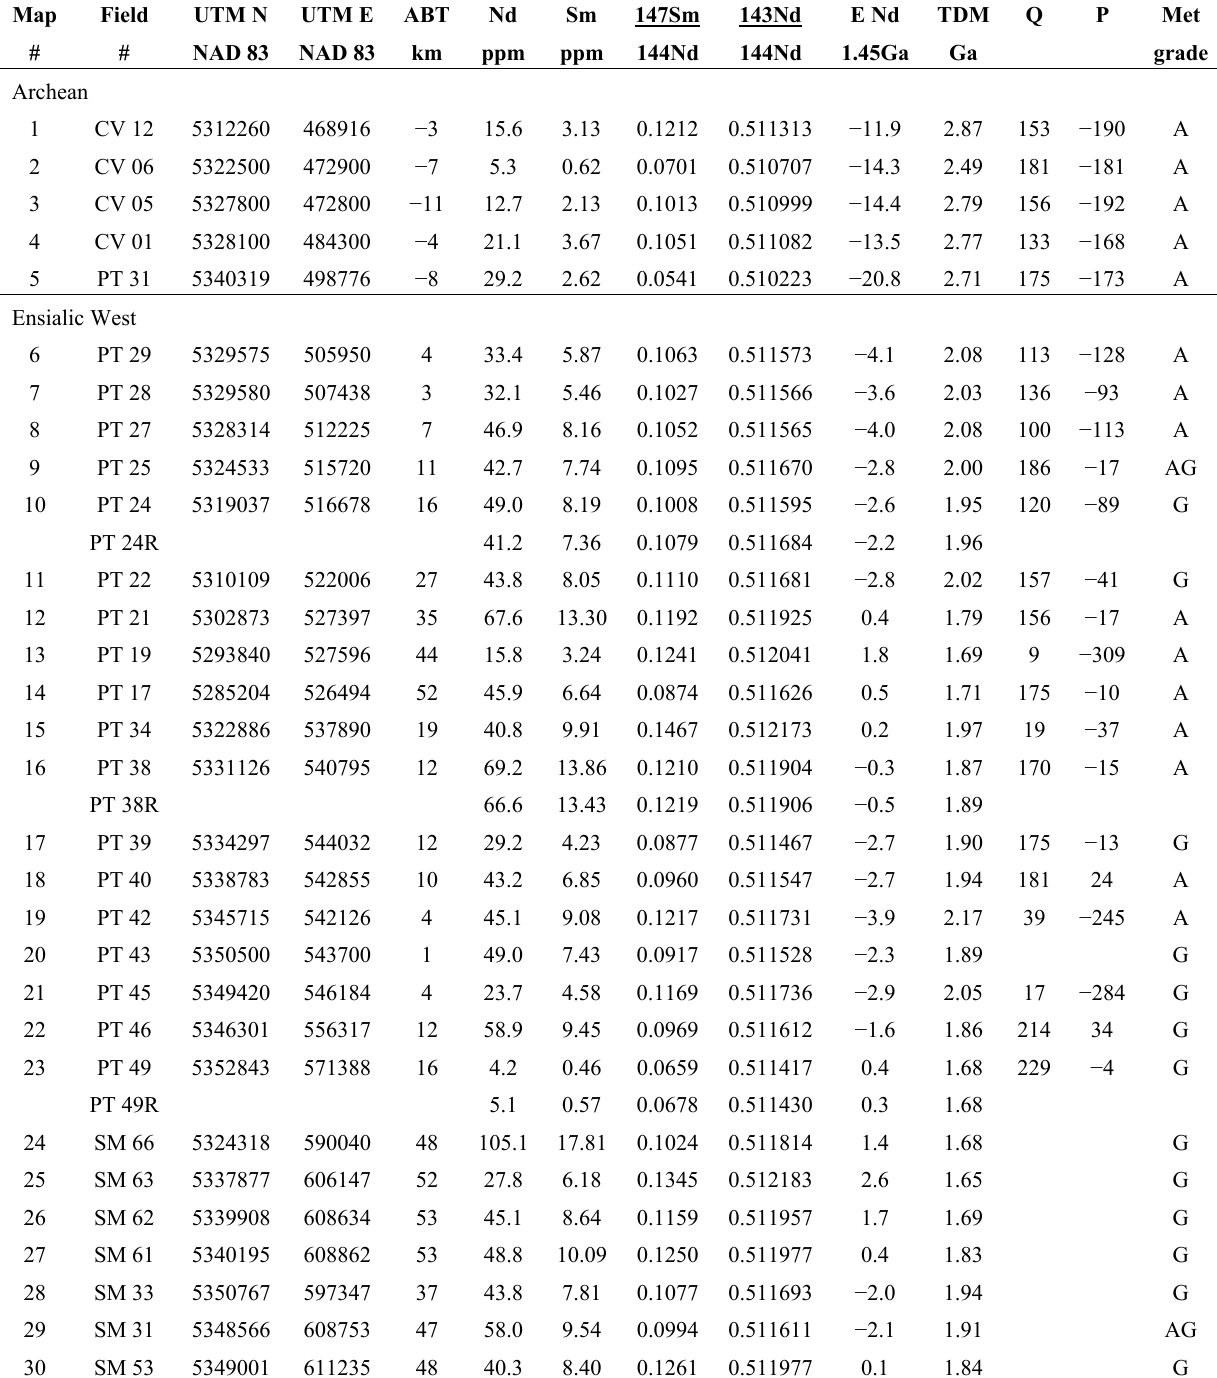
Table 1. Nd isotope data for the Parent-Clova area,